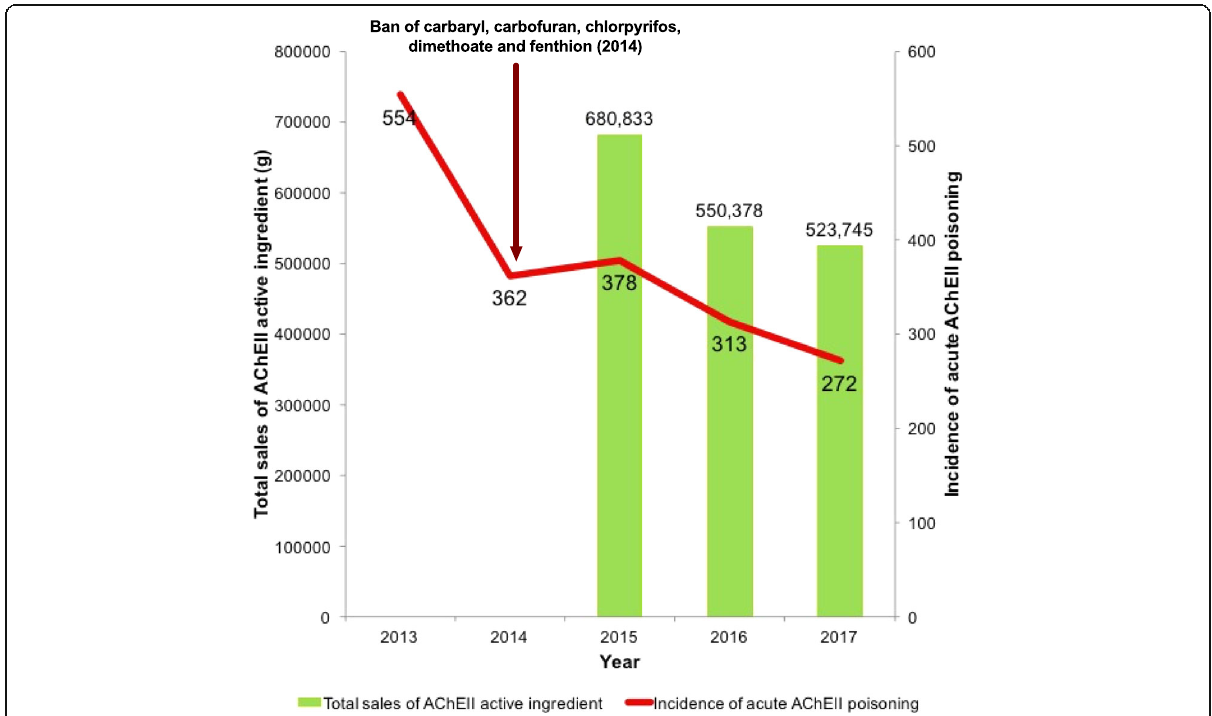
Fig. 5 Total sales of acetylcholinesterase inhibitor insecticides compared with the admissions of acute acetylcholinesterase inhibitor insecticide poisoning by year, AChEII study, Anuradhapura,